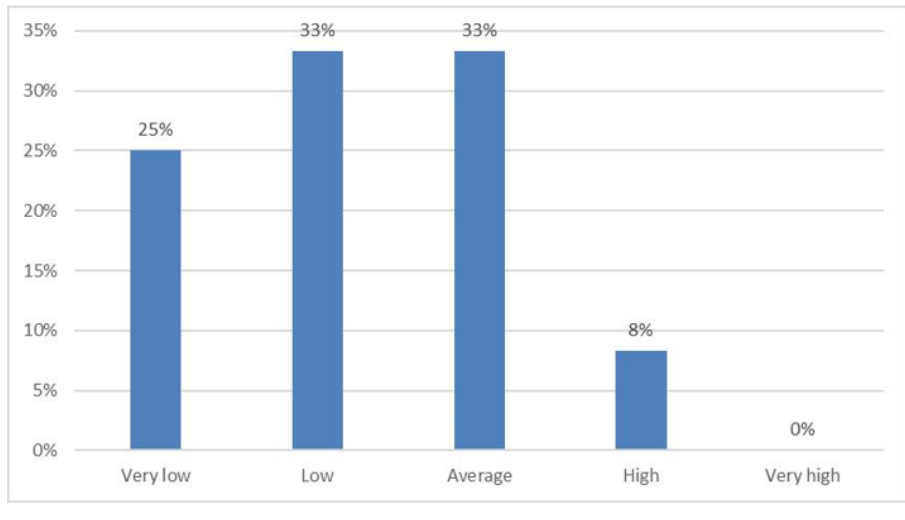
Figure 9. How Would You Evaluate the Degree to Which Your Supply Chain Has Withstood the Impacts of the COVID-19 Pandemic?